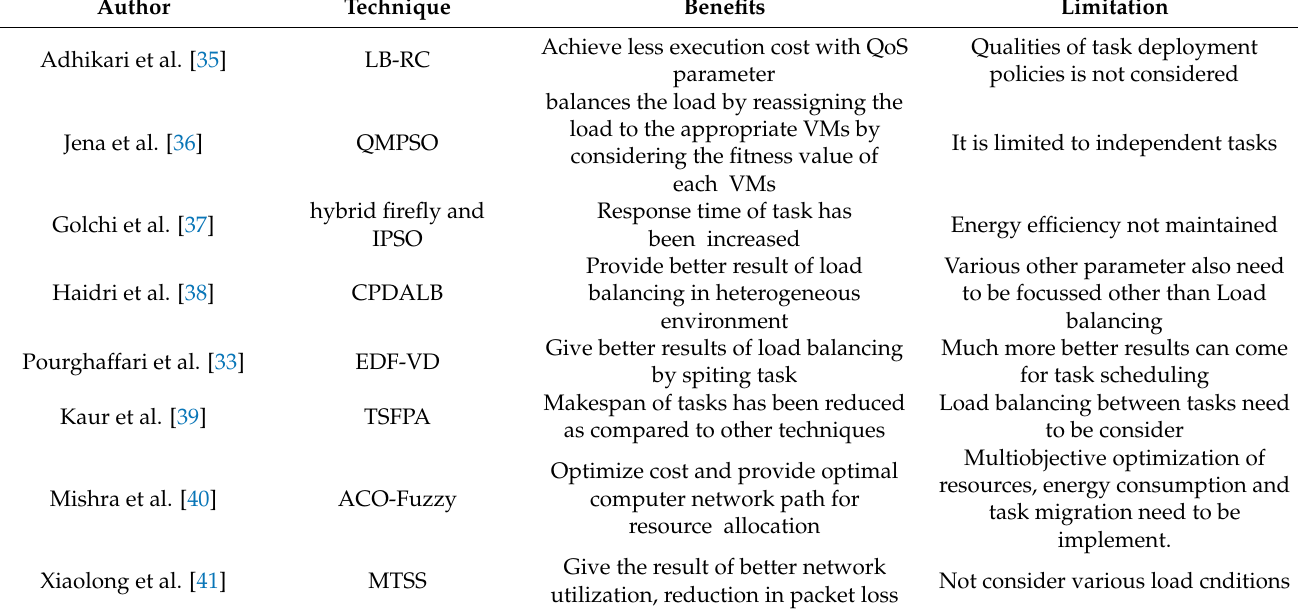
Table 1. Comparison of Various